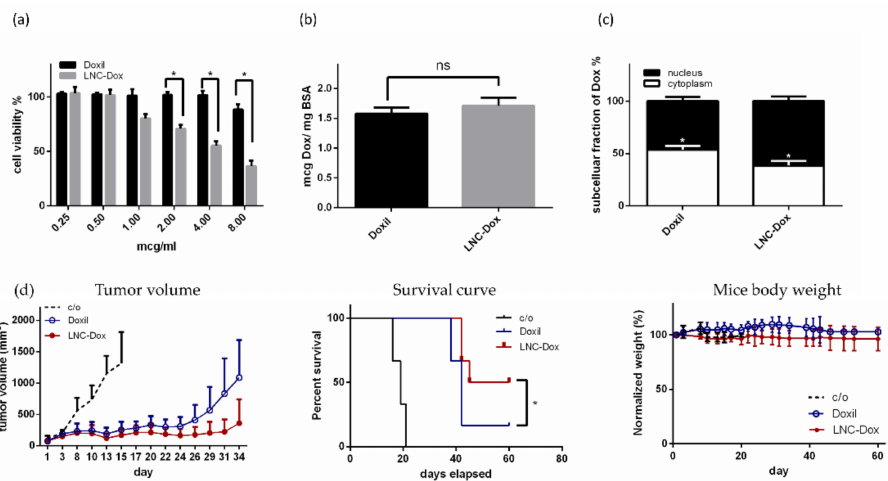
Figure 11. In vitro and in vivo therapeutic efficacy of the optimized LNC-Dox against murine C26 tumor cells: ( a ) In vitro cytotoxicity of Doxil ® and LNC-Dox (* p < 0.01). ( b ) Cellular uptake of Doxil ® and LNC-Dox. ( c ) Intracellular distribution of doxorubicin in C26 cells treated with Doxil ® and LNC-Dox (* p < 0.01). ( d ) Left: effects of Doxil ® and the optimized LNC-Dox on tumor progression (* p < 0.01). Middle: Kaplan–Meier analysis of survival of tumor-bearing mice treated with Doxil ® and the optimized LNC-Dox (* p < 0.05); survival times reflect the times at which mice were euthanatized due to the tumor size exceeding 2500 mm 3 . Right: measurement of body weight for the tumor- bearing mice treated with saline, Doxil ® , and the optimized LNC-Dox. Mice were intravenously administrated with the indicated drugs (10 mg/kg) twice (day 0 and day 7) during the treatment. Data are expressed as the mean ± SD for each group ( n =